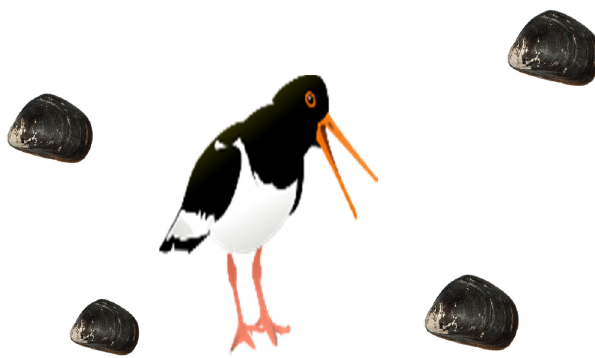
Figure 1: EO and the candidate